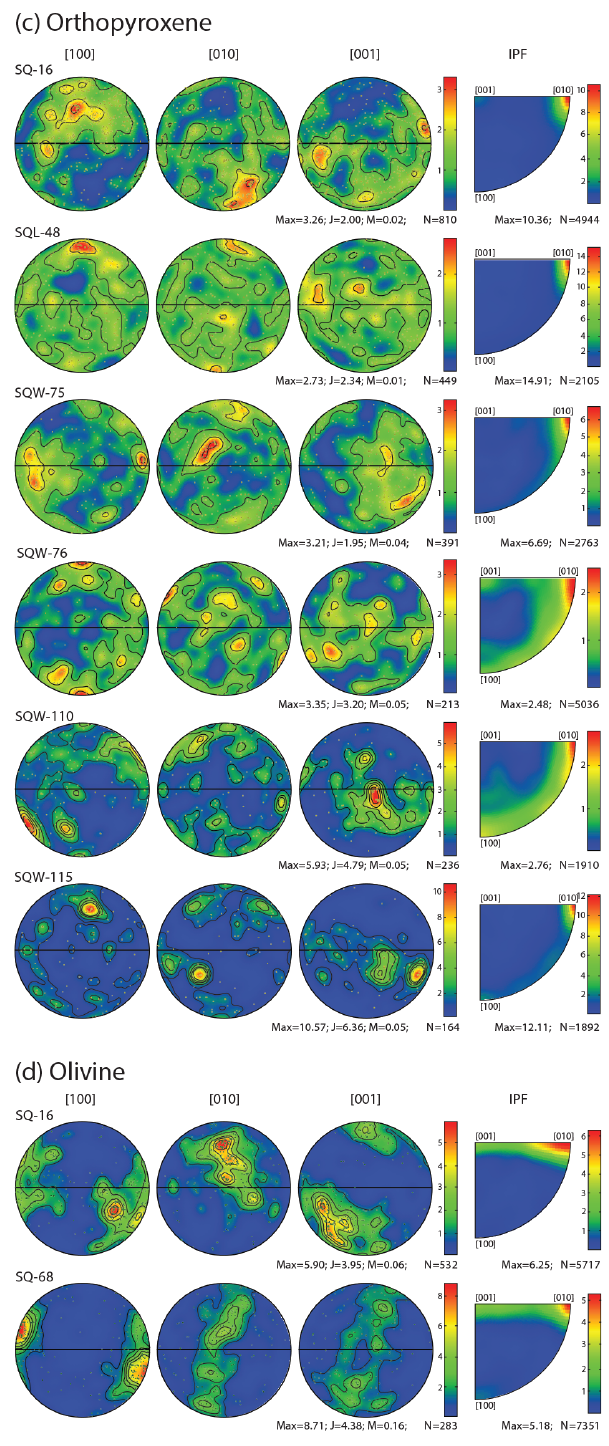
Figure 9. Equal area distributions of the crystallographic orientations and low-angle misorientations of (a) plagioclase, (b) clinopyroxene, (c) orthopyroxene, and (d) olivine grains. Crystallographic orientations are plotted as one point per grain data set in lower-hemisphere equal- area projections, relative to the observed foliation and lineation. Color scales are for multiples of uniform distribution. For each sample, the J index, M index, and the number of grains analyzed are given. Misorientation axes are from correlated misorientation angles between 2 and 10 ◦ . Inverse pole figures are in the crystallographic reference